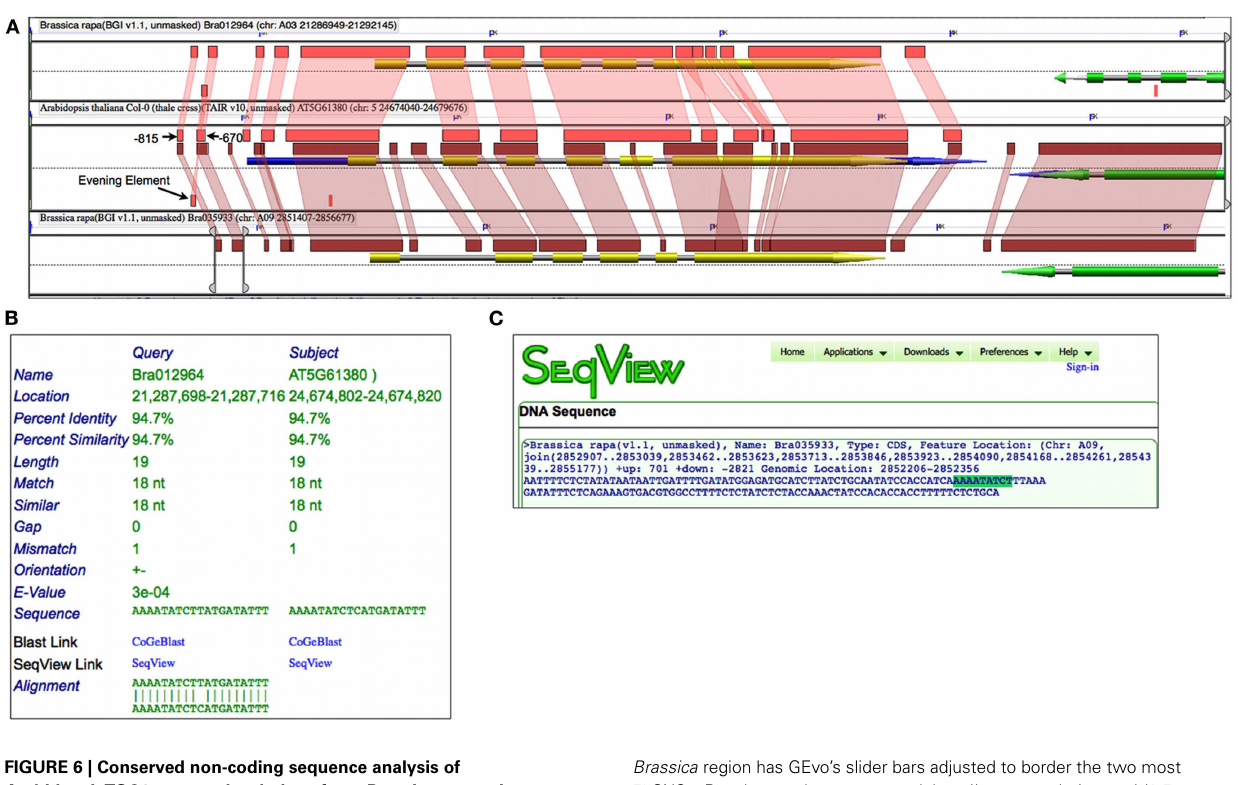
Brassica region has GEvo’s slider bars adjusted to border the two most 5 (cid:48) CNSs. Results may be regenerated: http://genomevolution.org/r/4t5e (B) HSPView’s report on the BlastN HSP containing Evening Element (AAAATATCT). (C) Using SeqView to visualize the sequence encompassing the two most 5 (cid:48) CNSs in Bra035933 with the Evening Element highlighted. Sequence can be obtained: http://